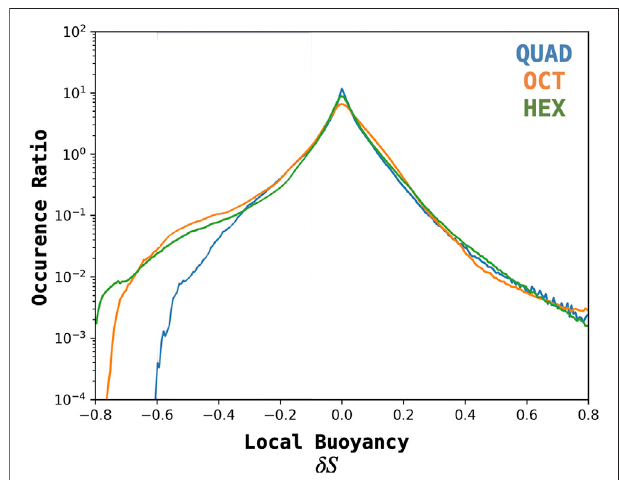
FIGURE 5 | Grid resolution study of the statistics of bubble depletion during SMC-like activity. Shown are statistics calculated using a grid 2 × coarser(QUAD)and2 × fi ner(HEX)thanthegridresolutionweuseelsewherein this paper